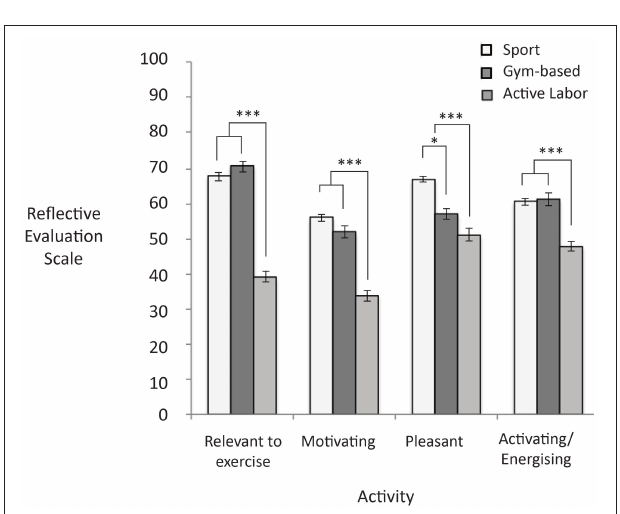
FIGURE 3 | Higher scores represent higher reflective evaluation ratings on the 0–100 response scale. Significant differences are noted with asterisks. Error bars reflect standard